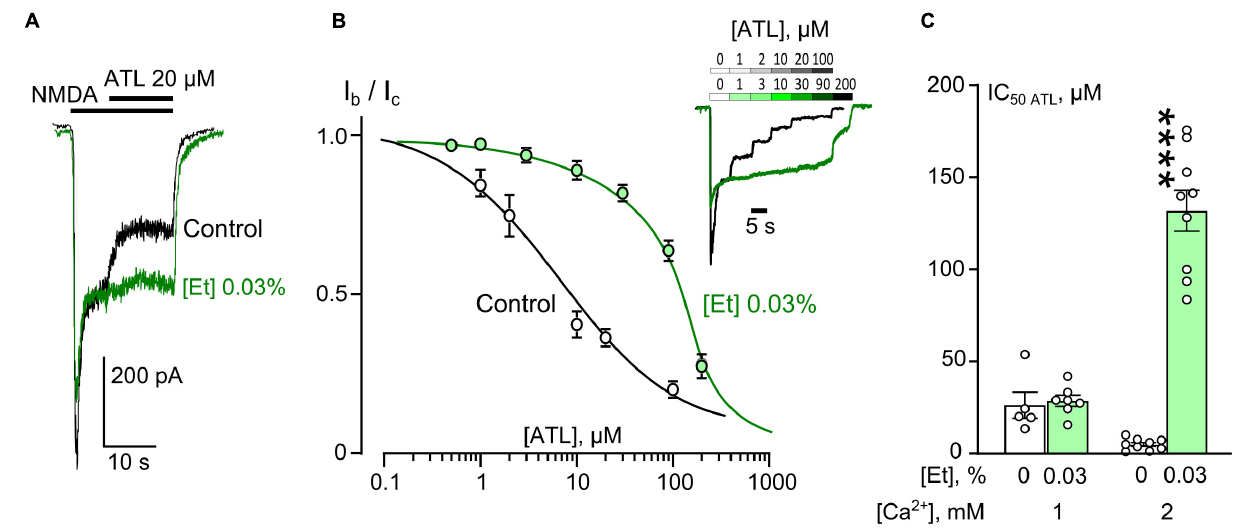
FIGURE 1 | Ethanol effects on amitriptyline (ATL) inhibition of NMDAR currents. (A) Currents activated by 100 µ M NMDA + 30 µ M Gly recorded at –70 mV in a single neuron in the bathing solution containing 2 mM [Ca 2 + ] in control and in the presence of 0.03% ethanol. 20 µ M ATL was applied at the steady state of NMDA-activated currents. (B) Concentration-inhibition curves for ATL of currents activated by 100 µ M NMDA + 30 µ M Gly in 2 mM [Ca 2 + ] in the control bathing solution or in ∼ 6 mM ethanol ([Et] 0.03%). Symbols show mean values ± SEM of the relative amplitudes of currents (I b /I c ) in the presence (I b ) and absence (I c ) of different ATL concentrations ([ATL]). In insert sample traces of NMDAR currents normalized to the steady-state amplitude without ATL, recorded at –70 mV in the presence of increasing [ATL] in control (upper row) and in ethanol (lower row) are shown. (C) Dependence of IC 50 for inhibition of NMDAR currents by ATL on extracellular [Ca 2 + ] and ethanol obtained from experiments illustrated in (A) . Data from each experiment (symbols) and mean values ± SEM are shown. Mean IC 50 values are summarized in Table 1 . Two-way ANOVA ([Ca 2 + ] × [Et]) revealed significant main effects of the [Ca 2 + ] [ F ( 1 , 25 ) = 33.9, p = 0.000004] and [Et] [ F ( 1 , 25 ) = 79.7, p = 0.000000003] and interaction between [Ca 2 + ] and [Et] [ F ( 1 , 25 ) = 59.5, p = 0.00000005]. Data obtained in 2 mM [Ca 2 + ] in ethanol and without ethanol differ significantly (**** p = 0.000000003), two-way ANOVA with post hoc Tukey’s